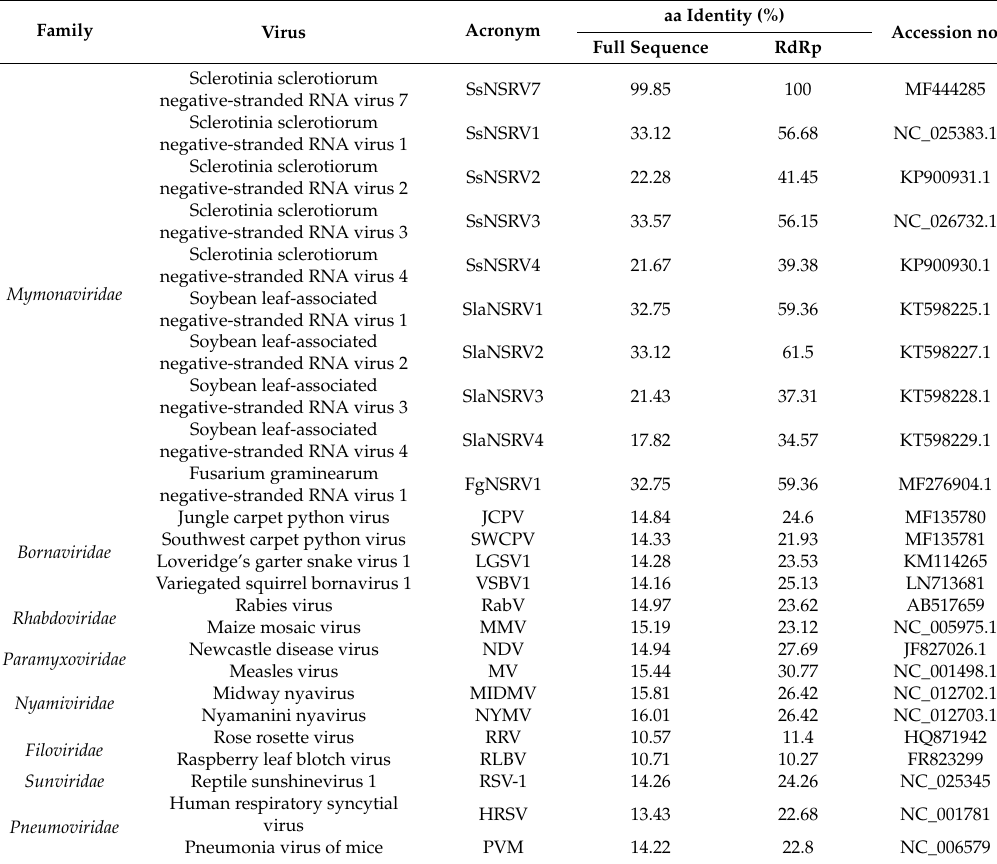
Table 1. Percentage of sequence identities between Botrytis cinerea mymonavirus 1 and other mononegaviruses according to the multiple alignments of the full-length protein L and the RNA-dependent RNA polymerase